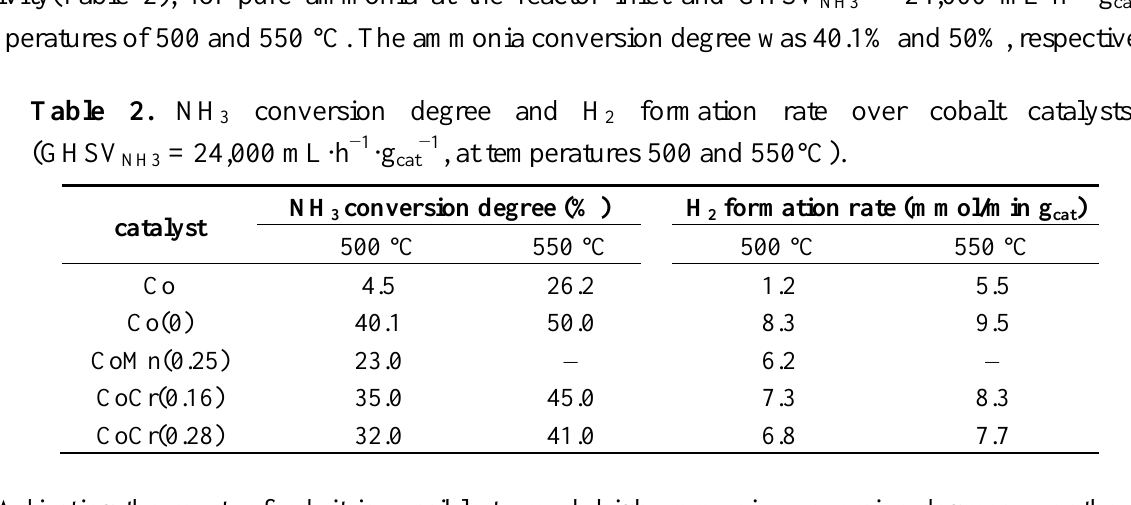
formation rate over cobalt catalysts 2